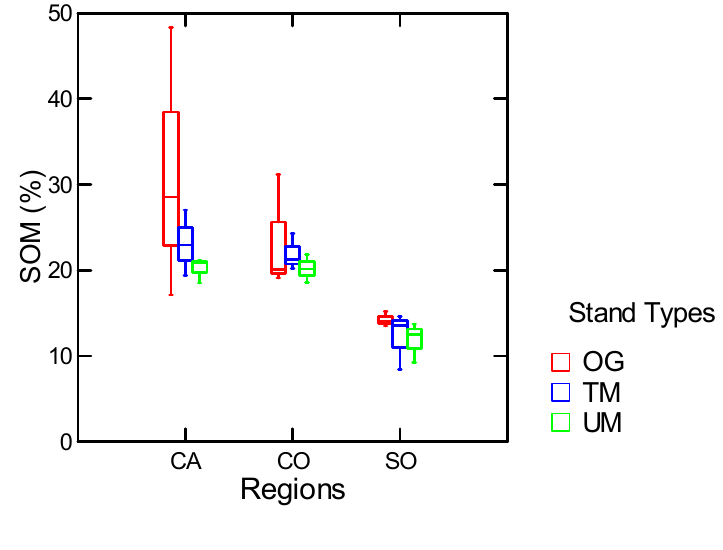
Figure 2. Box plot of percent soil organic matter (SOM) in the top 10 cm of mineral soil, by region and stand type. The center vertical line in each box = the median. The length of each box shows the range in which 50% of the values fall, with the upper and lower edges (“hinges”) marking the first and third quartiles. The whiskers extending from the hinges show the range of values that fall within 1.5× the interquartile range (IQR), where IQR = the absolute difference between the first and third quartiles